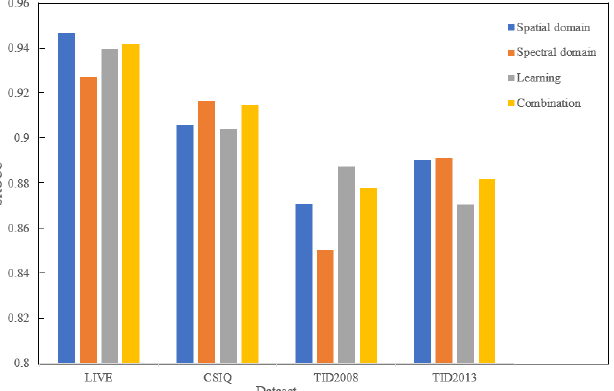
Figure 10. SROCC value of different groups of methods on analog distortion datasets.